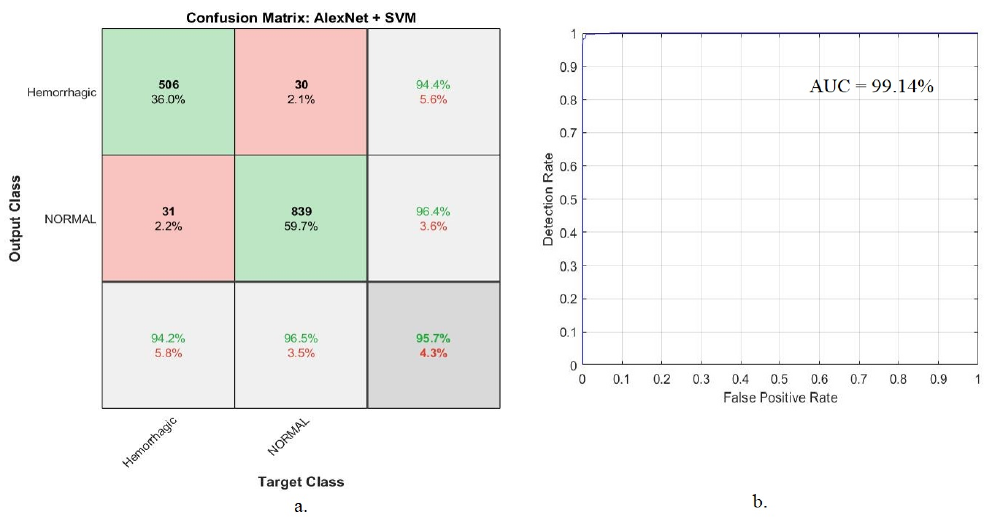
Figure 14. Performance of the AlexNet + SVM model for diagnosing the hemorrhage dataset. ( a ) Confusion matrix. ( b )